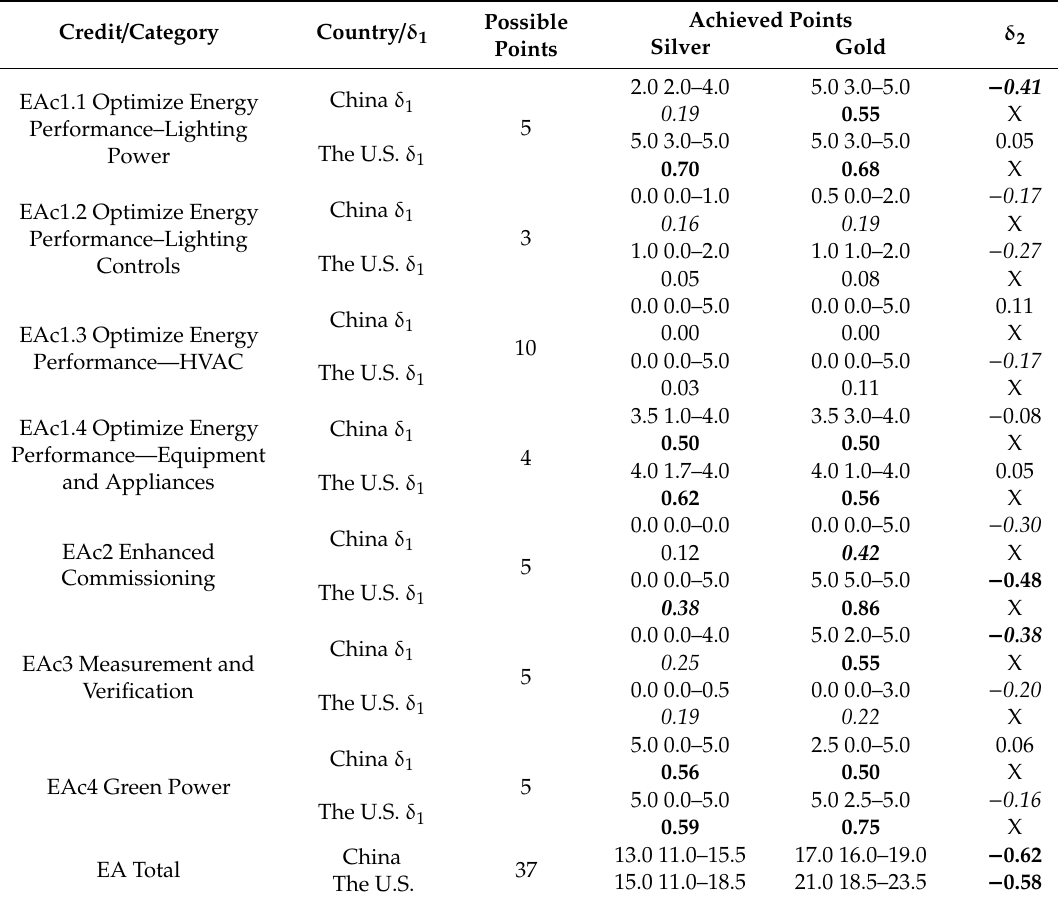
Table 5. LEED-CIv3 Energy and Atmosphere (EA) credits category: The median and 25th–75th centiles and Cli ff ’s e ff ect size ( δ 1 ) of the di ff erence between the achieved and the possible points, and ( δ 2 ) of the di ff erence between Silver and Gold projects in China and the